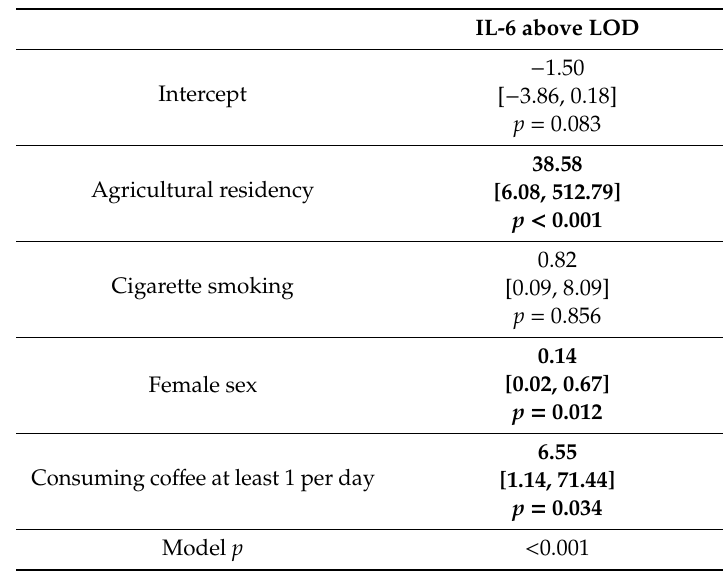
Table 4. Results of the multivariate logistic regression model for IL-6 in